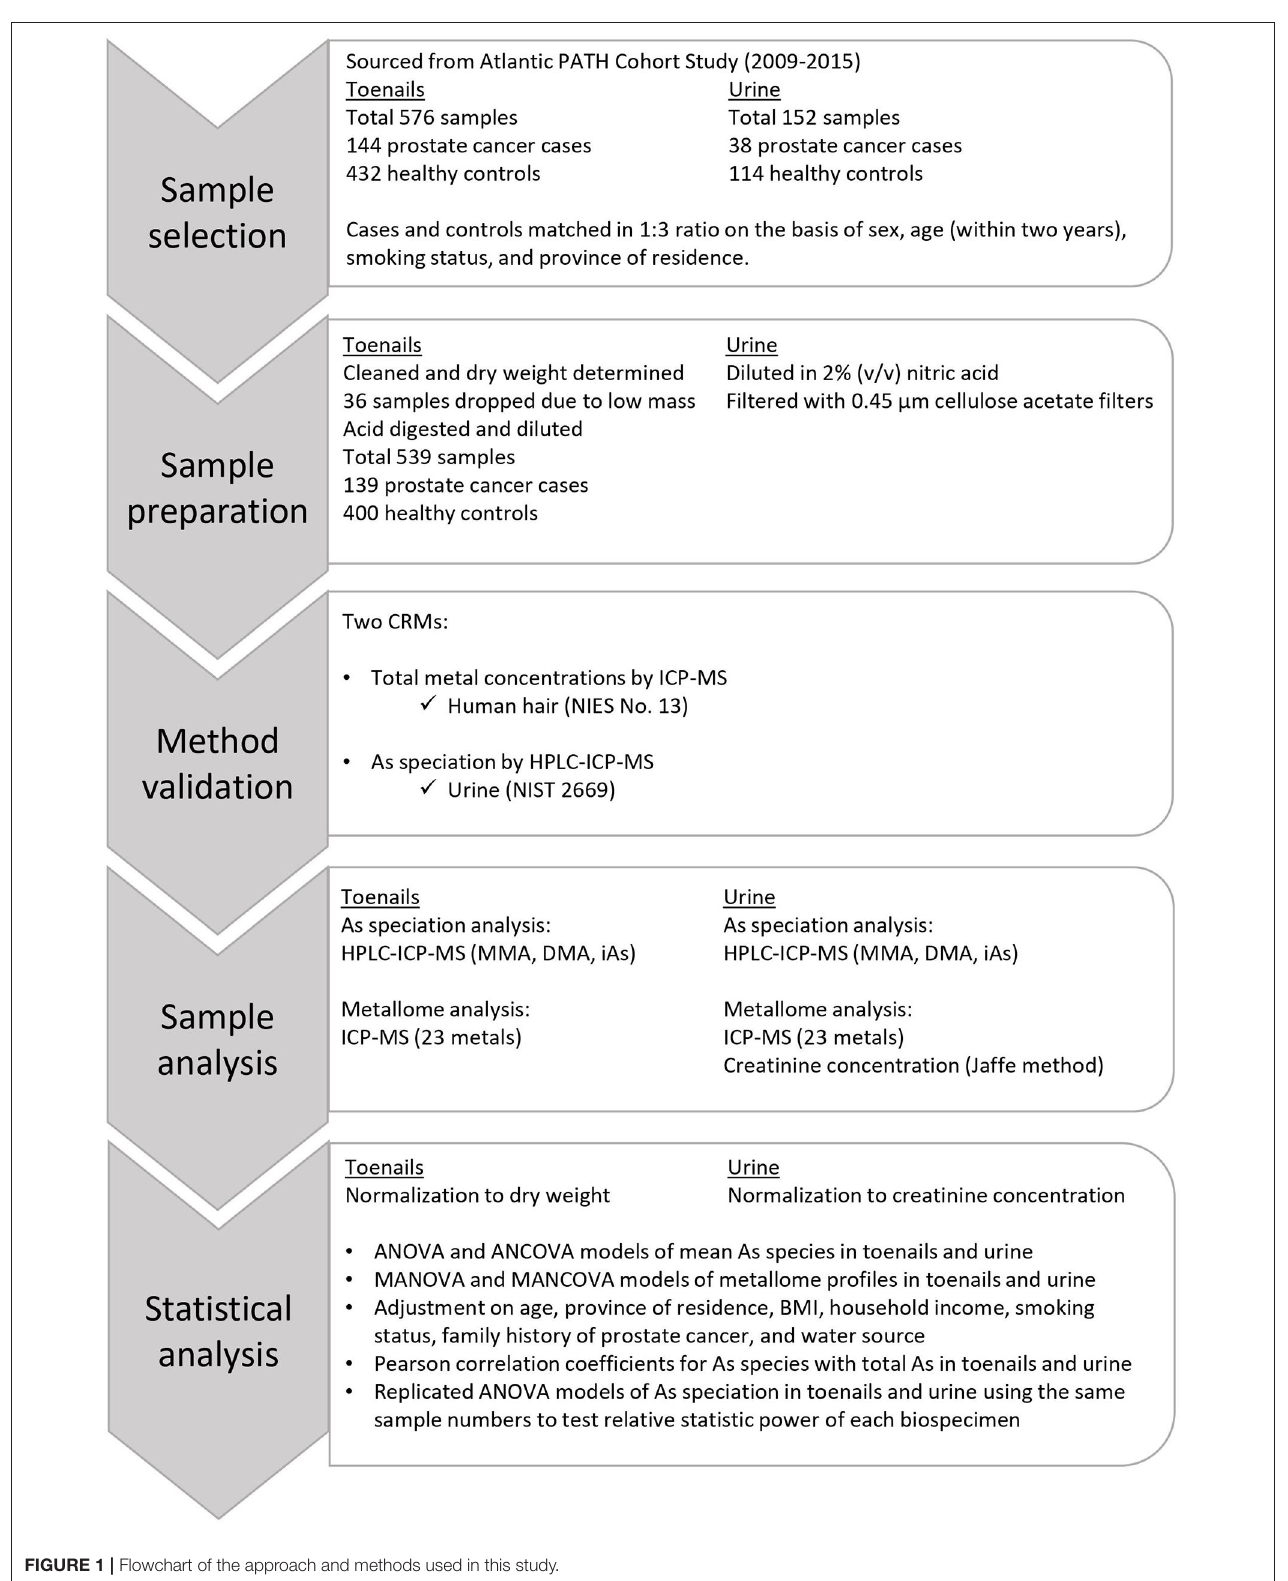
FIGURE 1 | Flowchart of the approach and methods used in this study.